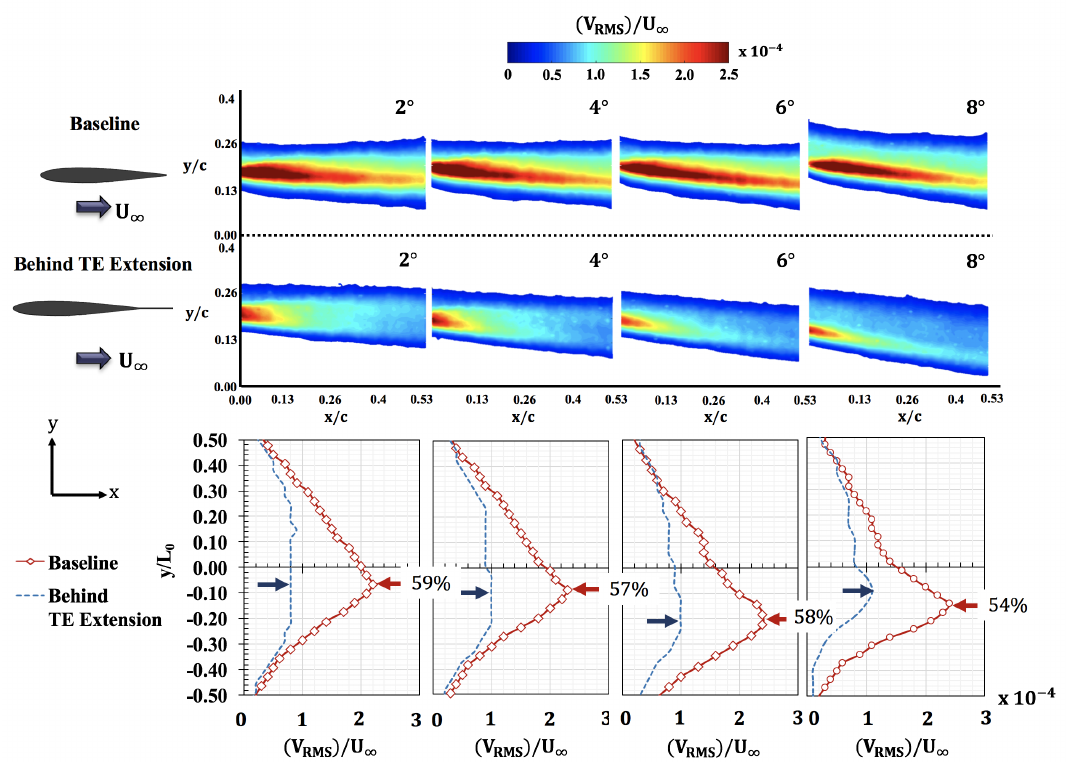
Figure 20. Streamwise V RMS contours and profiles in FSL behind the trailing edge of the NACA 0012 wing and behind the TE extension at different angles of attack for both cases. Large decreases where observed in the V RMS of the TE